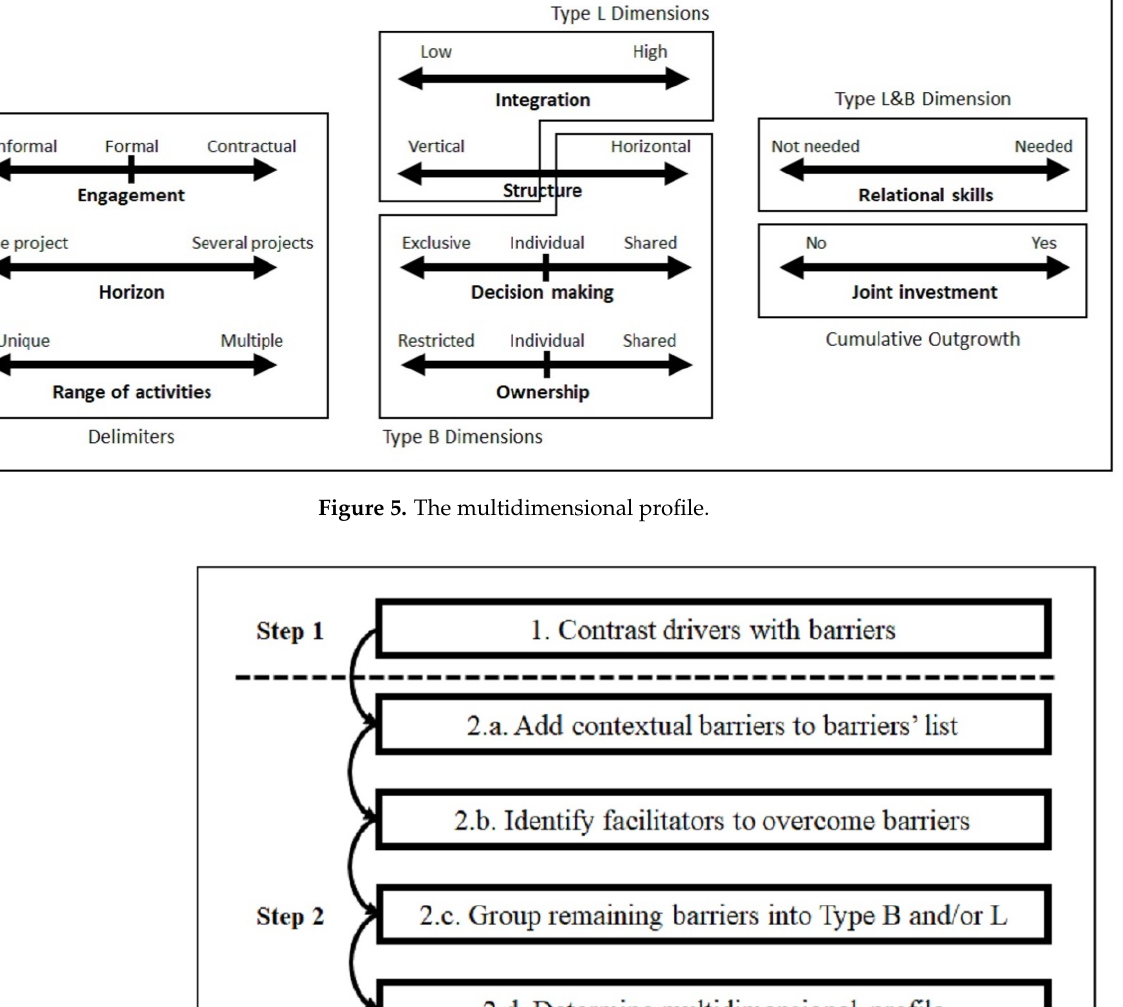
Figure 5. The multidimensional profile.